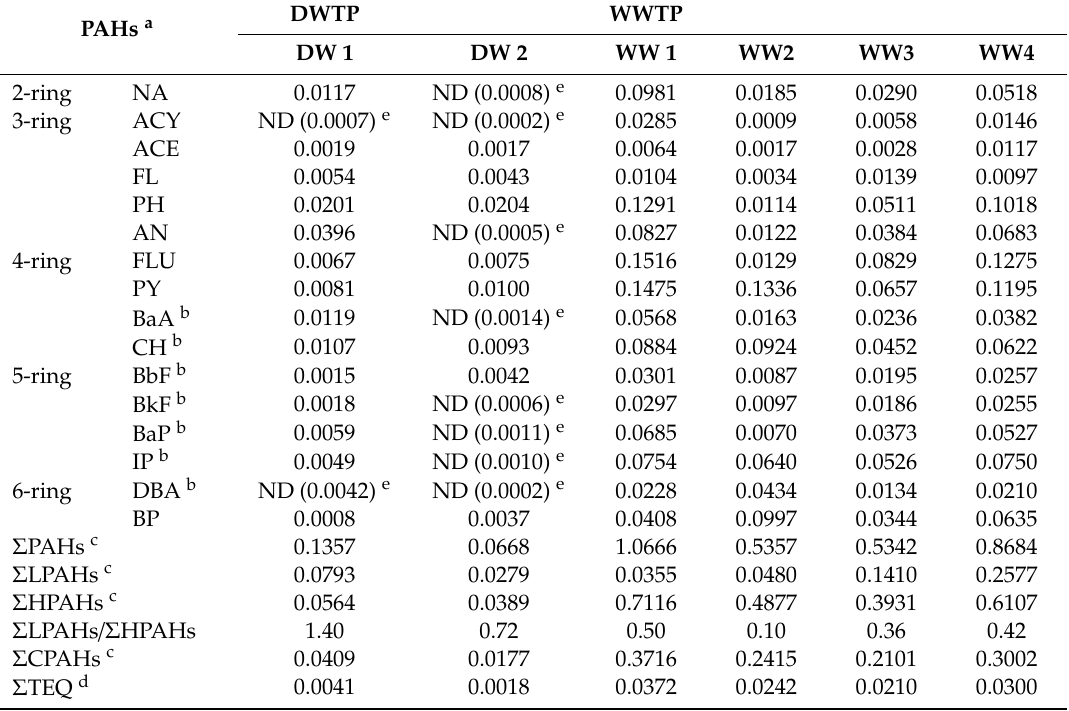
Table 4. PAHs content (mg / kg dw) of sludge from selected drinking water treatment plants (DWTP) and wastewater treatment plants (WWTP) in southwestern